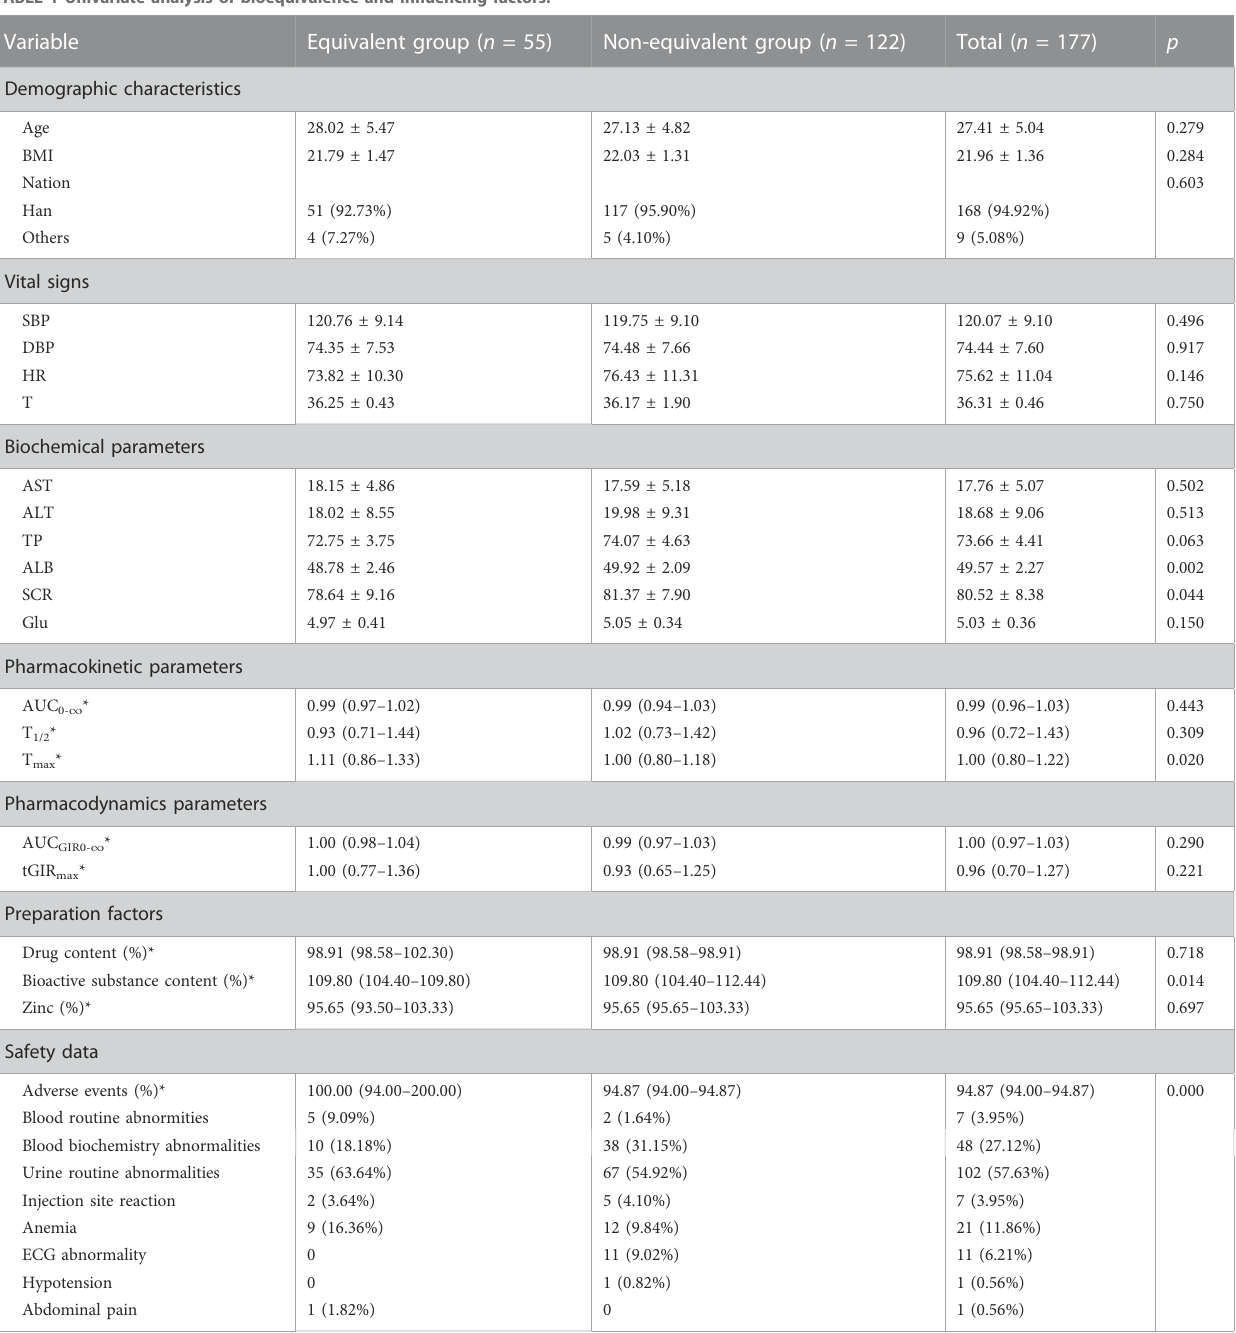
TABLE 1 Univariate analysis of bioequivalence and in fl uencing